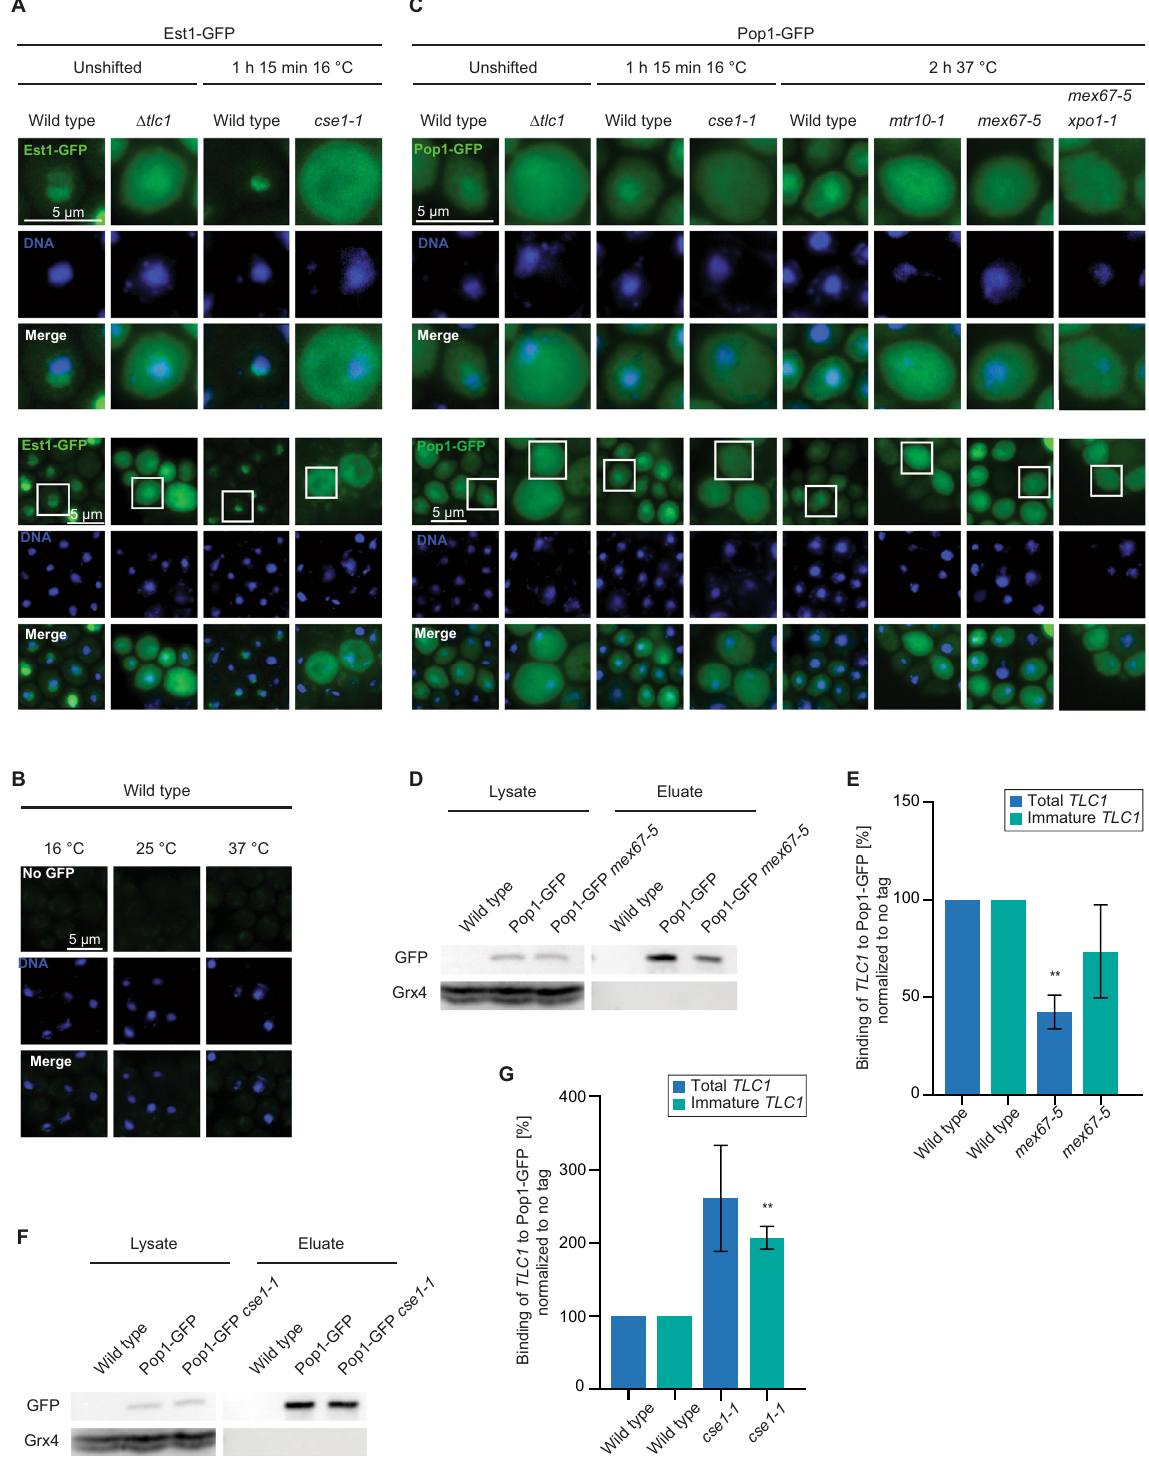
Figure 4. Loading of the Est and Pop proteins occurs in the cytoplasm. ( A ) Nuclear GFP-tagged Est1 mis-localizes to the cytoplasm in cse1-1 cells. n = 3 . ( B ) A wild type strain is shown without a GFP tagged protein with identical microscopy settings as shown in ( A ). ( C ) Nuclear Pop1 localization is disturbed in mutants affecting TLC1 localization. n = 3 . ( D ) Western blot of the Pop1-GFP IP is shown in the indicated strains. Grx4 served as a negative control. n = 3 . Image was cropped from the original. Original image can be found in Supplementary Fig. S4A. ( E ) Pop1 binding to TLC1 is decreased in an export mutant. The Pop1-bound RNA from the several IP, one of which is shown in D, was analyzed in qPCRs n = 3 . ( F ) Western blot of the Pop1-GFP IP is shown in the indicated strains. Grx4 served as a negative control. n = 3 . Image was cropped from the original. Original image can be found in Supplementary Fig. S4A. ( G ) Pop1 binding to TLC1 is increased in an import mutant. The Pop1-bound RNA from the several IP, one of which is shown in F, was analyzed in qPCRs. n = 3